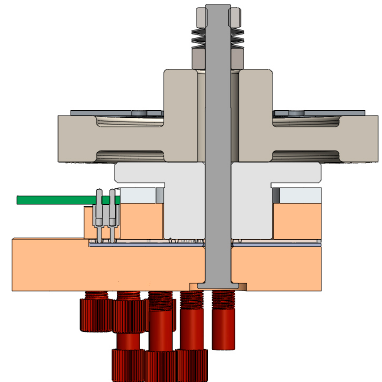
Figure A3. Cross-sectional view of the rotary valve. The fluidic connections are at the bottom side of the chip-holder. The central pin of the valve is fixed in the chip-holder and extends through the chip, the rotor and the gear. Spring discs are used to supply an even pressure on the